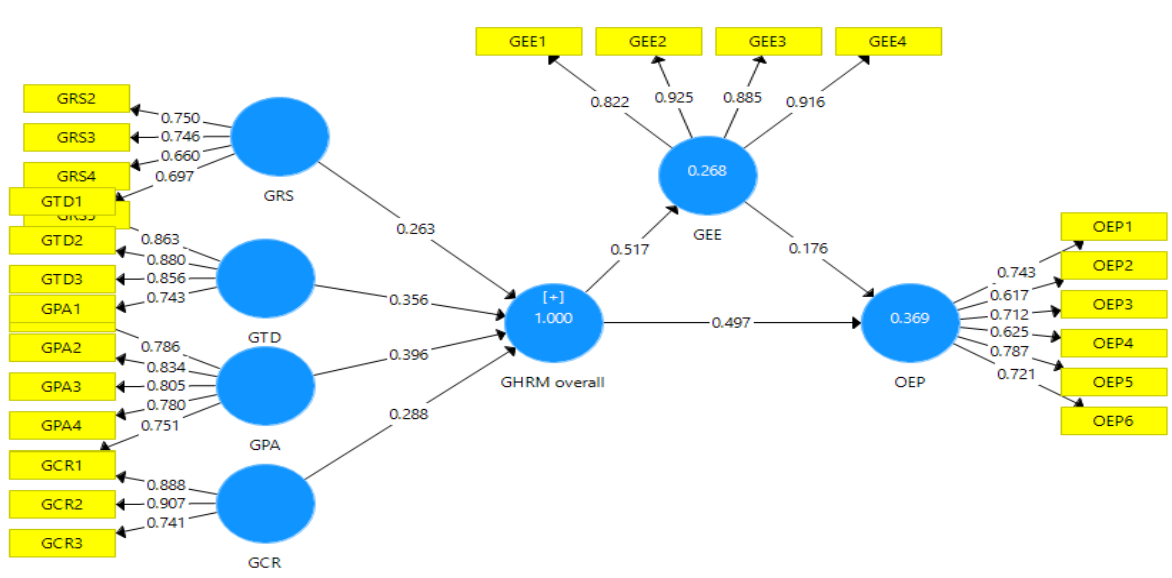
Figure 2: The Measurement Model of the